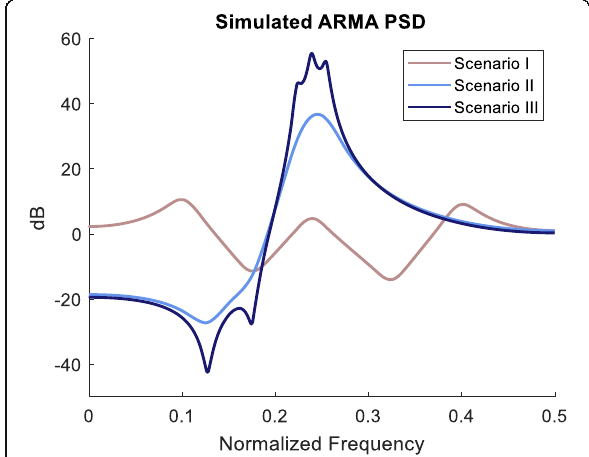
Fig. 2 The simulated time-invariant ARMA PSDs for Scenarios I, II, and